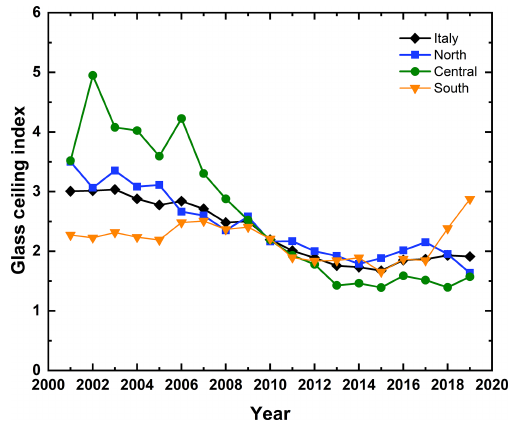
Figure 6. Glass Ceiling Index (GCI) calculated in Italy from 2001 to 2019. GCI is also provided for Northern, Central and South- ern Italy (data source: MIUR, https://cercauniversita.cineca.it/php5/ docenti/cerca.php, last access: 31 October 2019). Table 6. Glass ceiling index. National average and specific in- dexes calculated for Northern, Central and Southern Italy from 2001 to 2019 (data source: MIUR, https://cercauniversita.cineca.it/php5/ docenti/cerca.php, last access: 31 October 2019). GCI